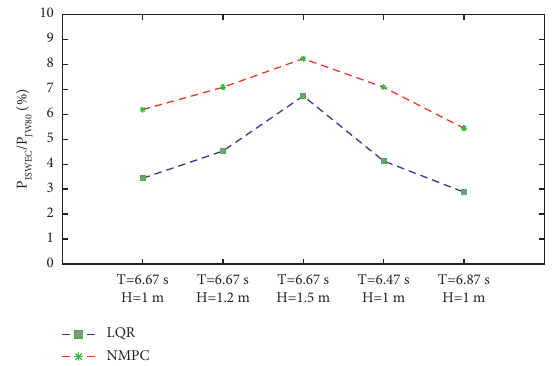
Figure 9: The compared power compensation ratio by LQR method and NMPC method,